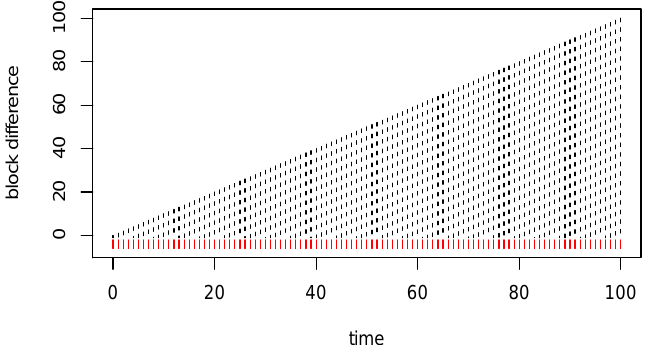
Figure 2. Solution to optimal stopping problem (18) . The continuation region is depicted by dashed lines, while and the stopping regions by solid Fig. 2: Solution to optimal stopping problem (5.9) .The continuation region is de- picted by dashed lines, while and the stopping regions by solid lines.